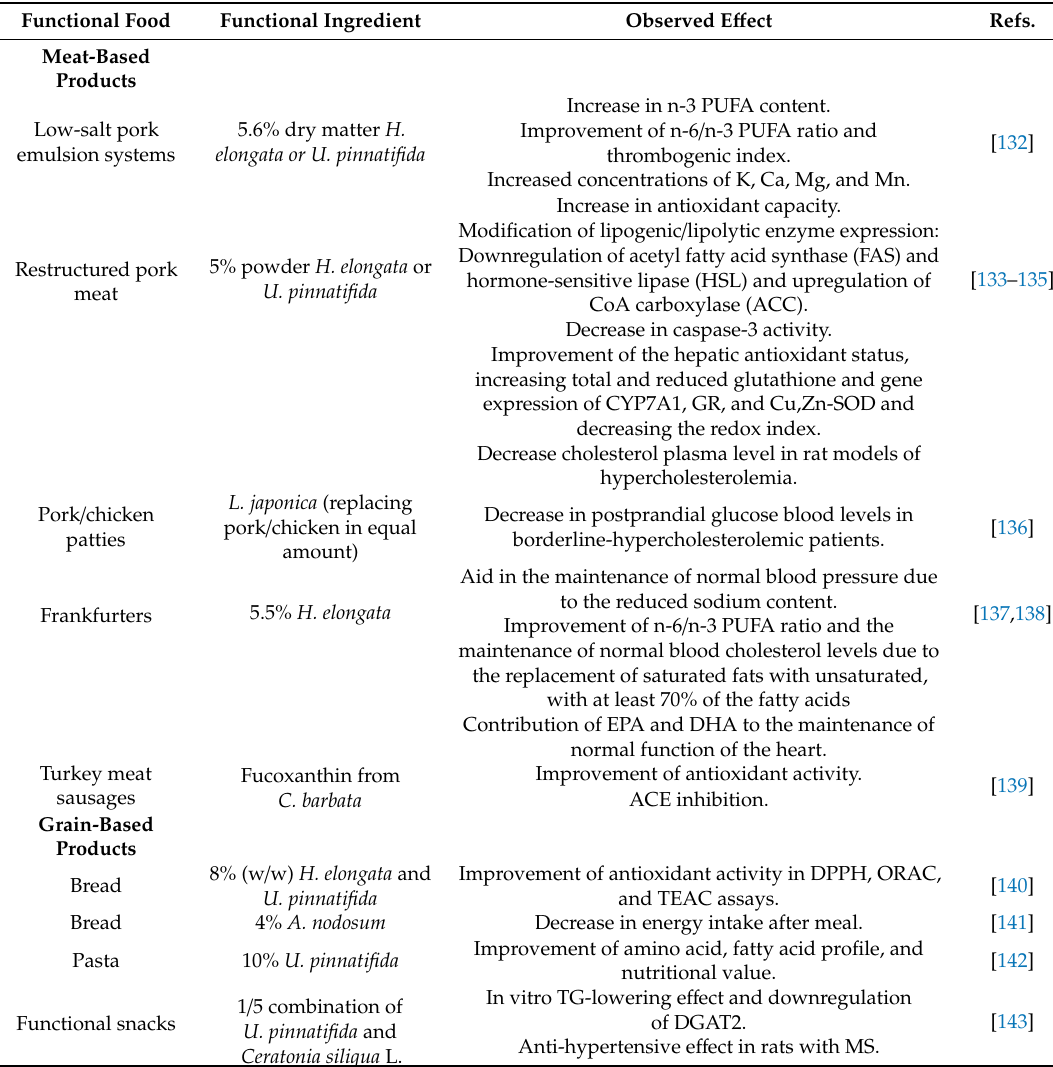
Table 3. Principal studies investigating the potential use of brown seaweeds as functional food ingredients to improve